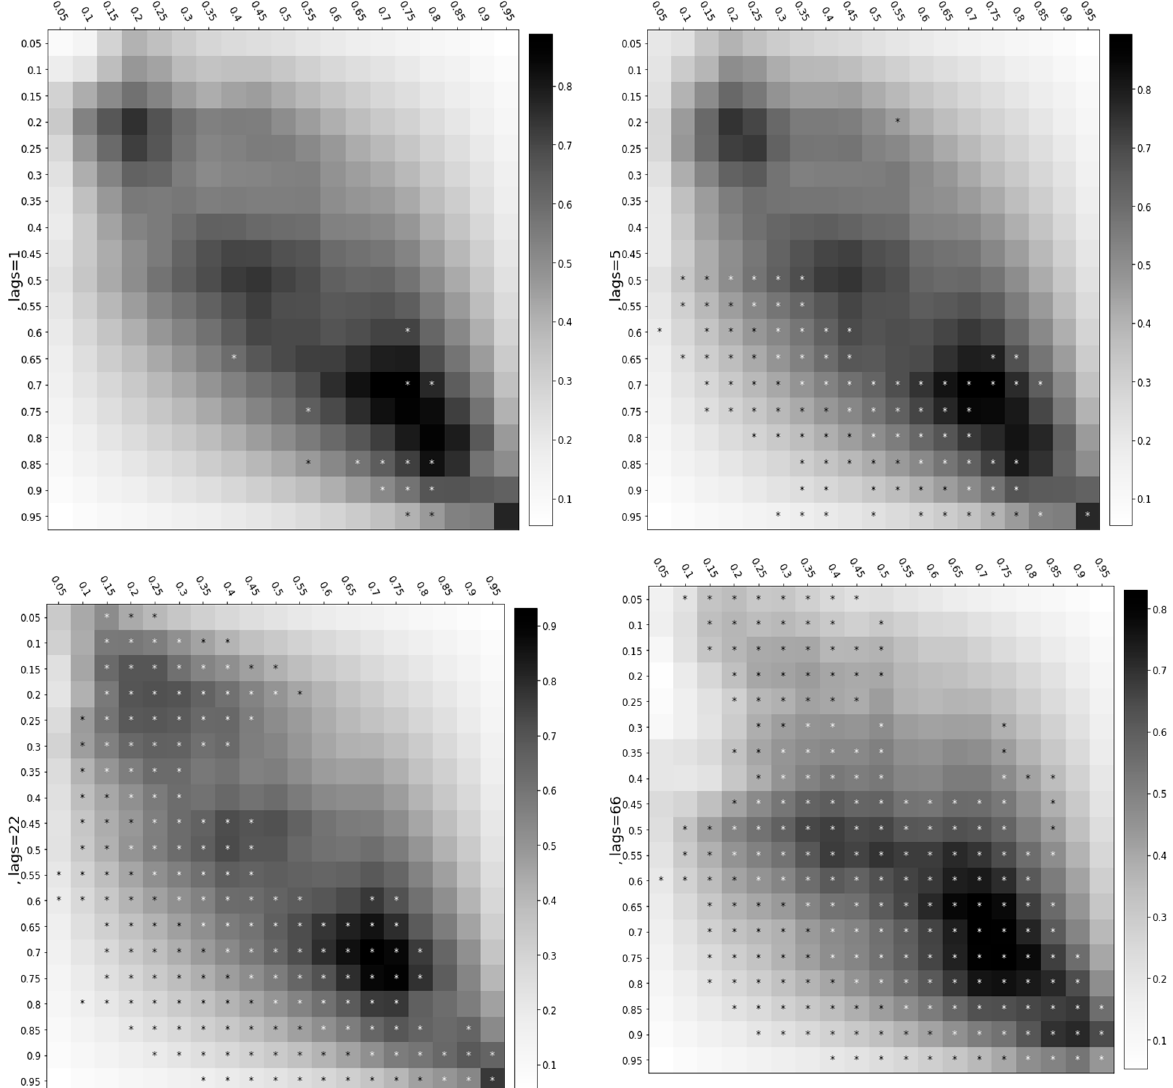
Figure 10. Cross-quantile dependency from Moderna to Johnson & Johnson. Notes: The vertical axis indicates the quantile distribution of Moderna’s stock return, whereas the horizontal axis indicates quantile distribution of Johnson & Johnson’s stock return. The white-to-black intensity in the bar indicates negative to positive associations.